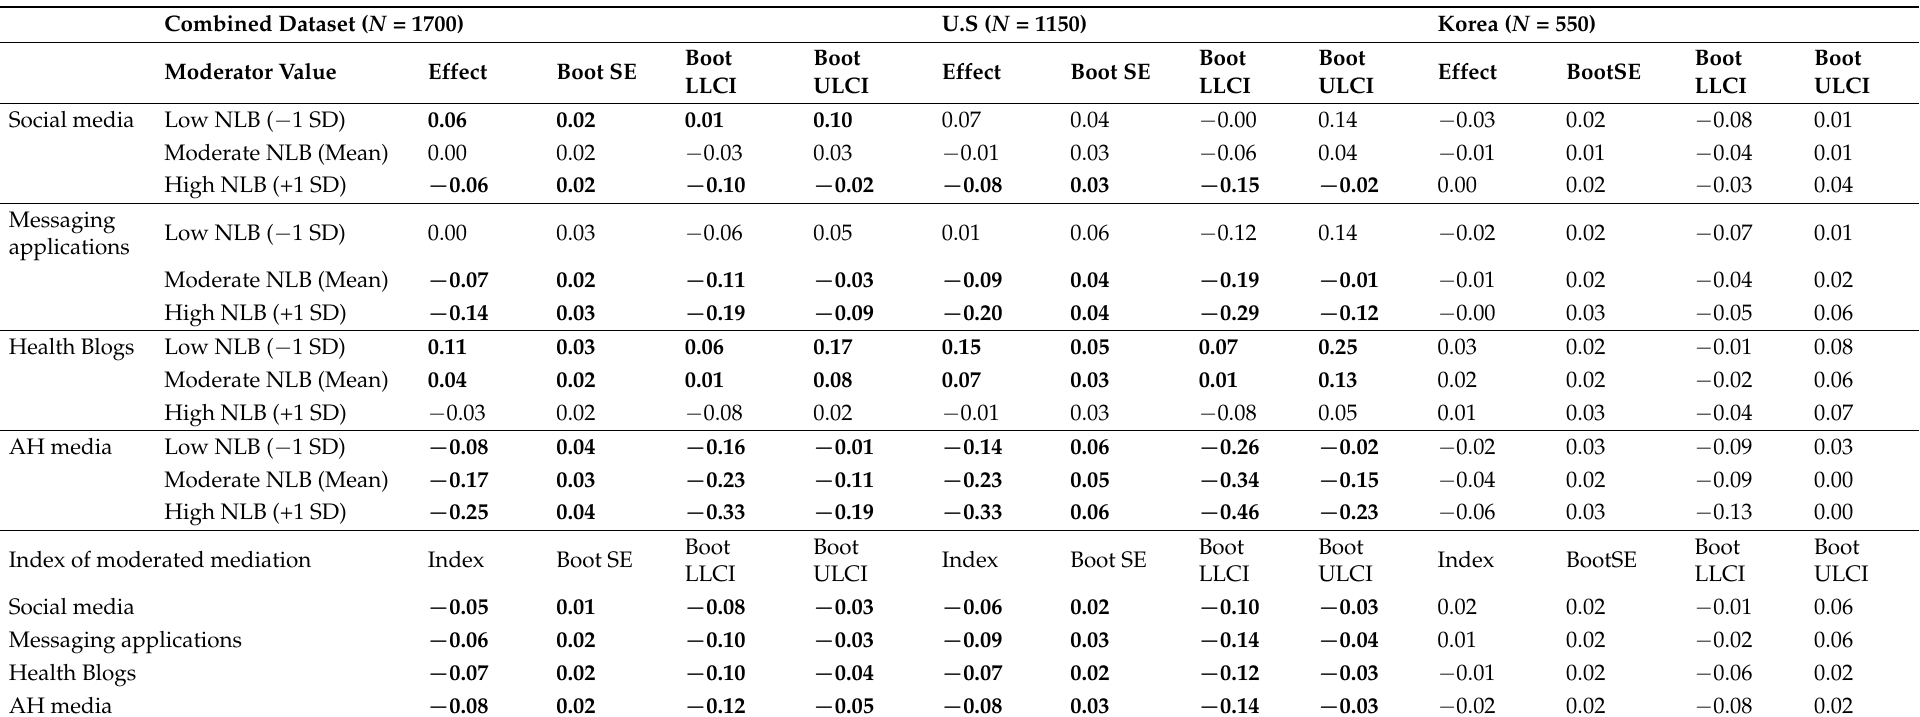
Table A5. Data analysis using 10,000 bootstrap samples (moderated mediation